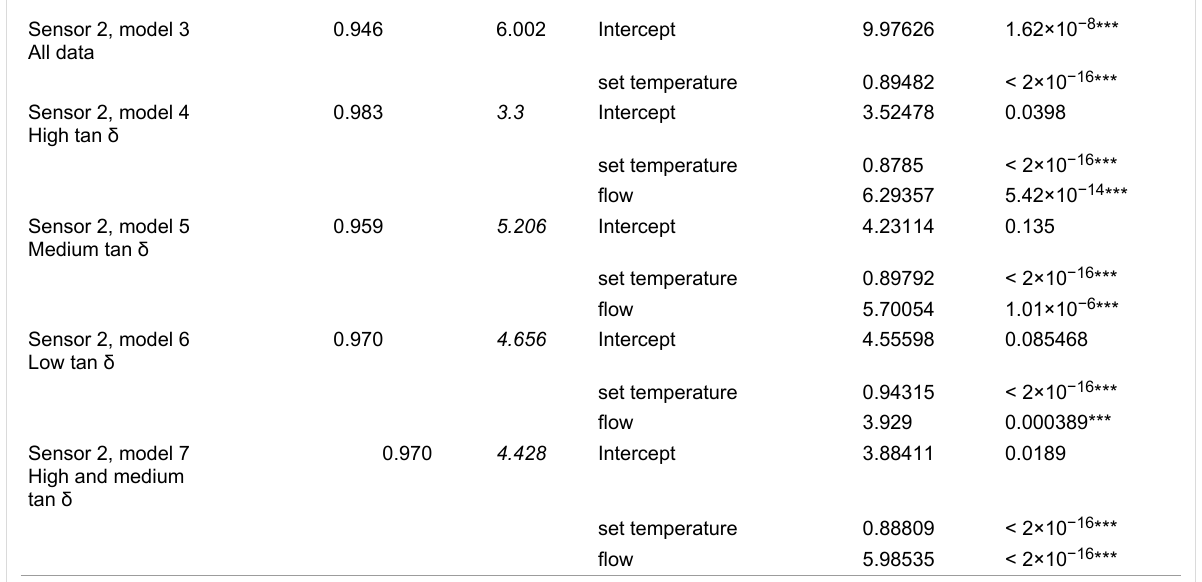
Table 3: Linear multiple regression models for IR sensor 2. (continued)